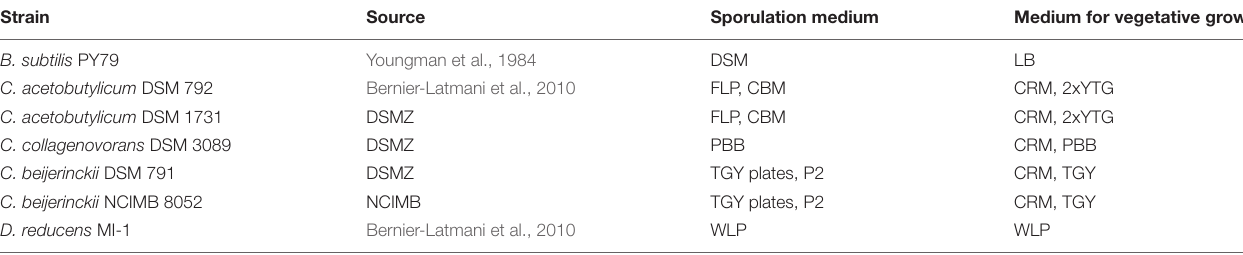
TABLE 1 | Bacterial strains used in the study.